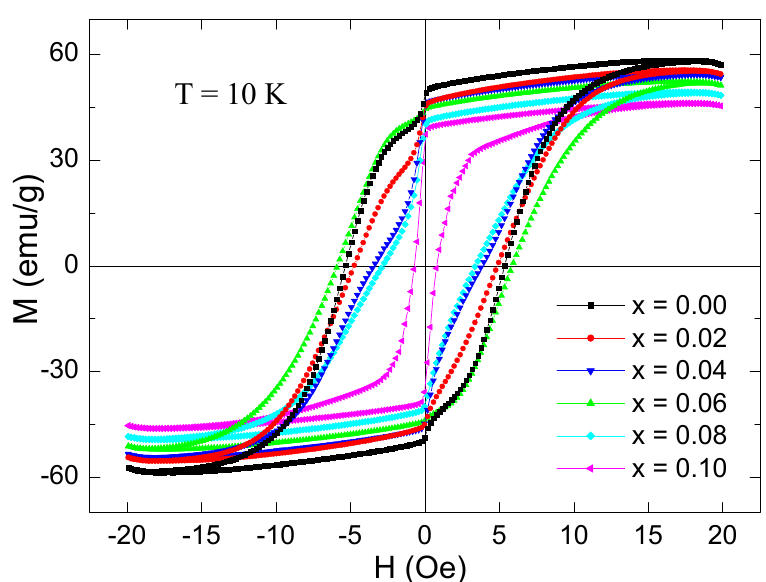
Figure 10. Magnetization against an applied field of ± 20 kOe, M (H), for all of the Co 0.5 Ni 0.5 Fe 2 − x O 4 (0.0 ≤ x ≤ 0.10) nanoparticles at 10 K.